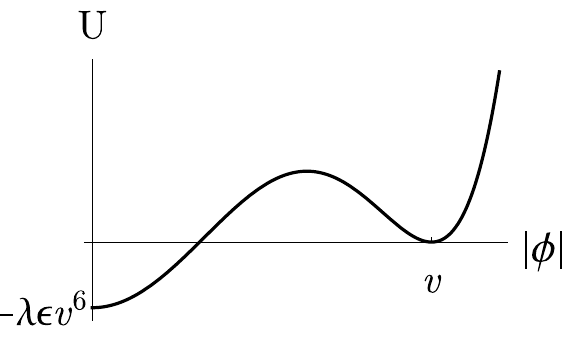
Figure 1. Potential energy